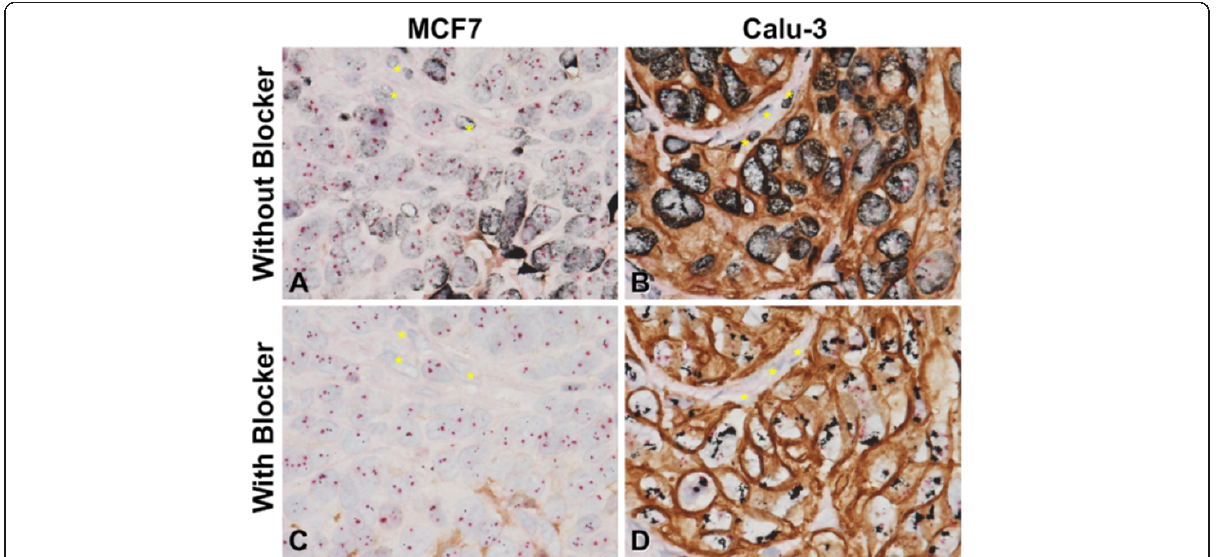
Figure 2 Naphthol phosphate blocks silver background staining resulting from the HER2 & CEN17 BISH procedure. Images show HER2 gene-protein staining results obtained without ( A , B ) or with naphthol phosphate ( C , D ) on formalin-fixed, paraffin-embedded (FFPE) HER2- negative MCF7 ( A , C ) and HER2-positive Calu-3 ( B , D ) xenograft tumors. In the absence of naphthol phosphate, non-specific silver deposition from the HER2 BISH detection procedure obscures the BISH signals for the HER2 gene and CEN17 targets ( A , B ) whereas the use of a BISH hybridization buffer containing naphthol phosphate eliminates the non-specific silver deposition ( C , D ). Some silver deposition was also seen in DAB staining ( A ). In the absence of naphthol phosphate, non-specific silver deposition occurred in mouse cells (yellow asterisks) ( A , B ) and mouse cells were confirmed without HER2 and CEN17 BISH signals by using naphthol phosphate ( C , D ).